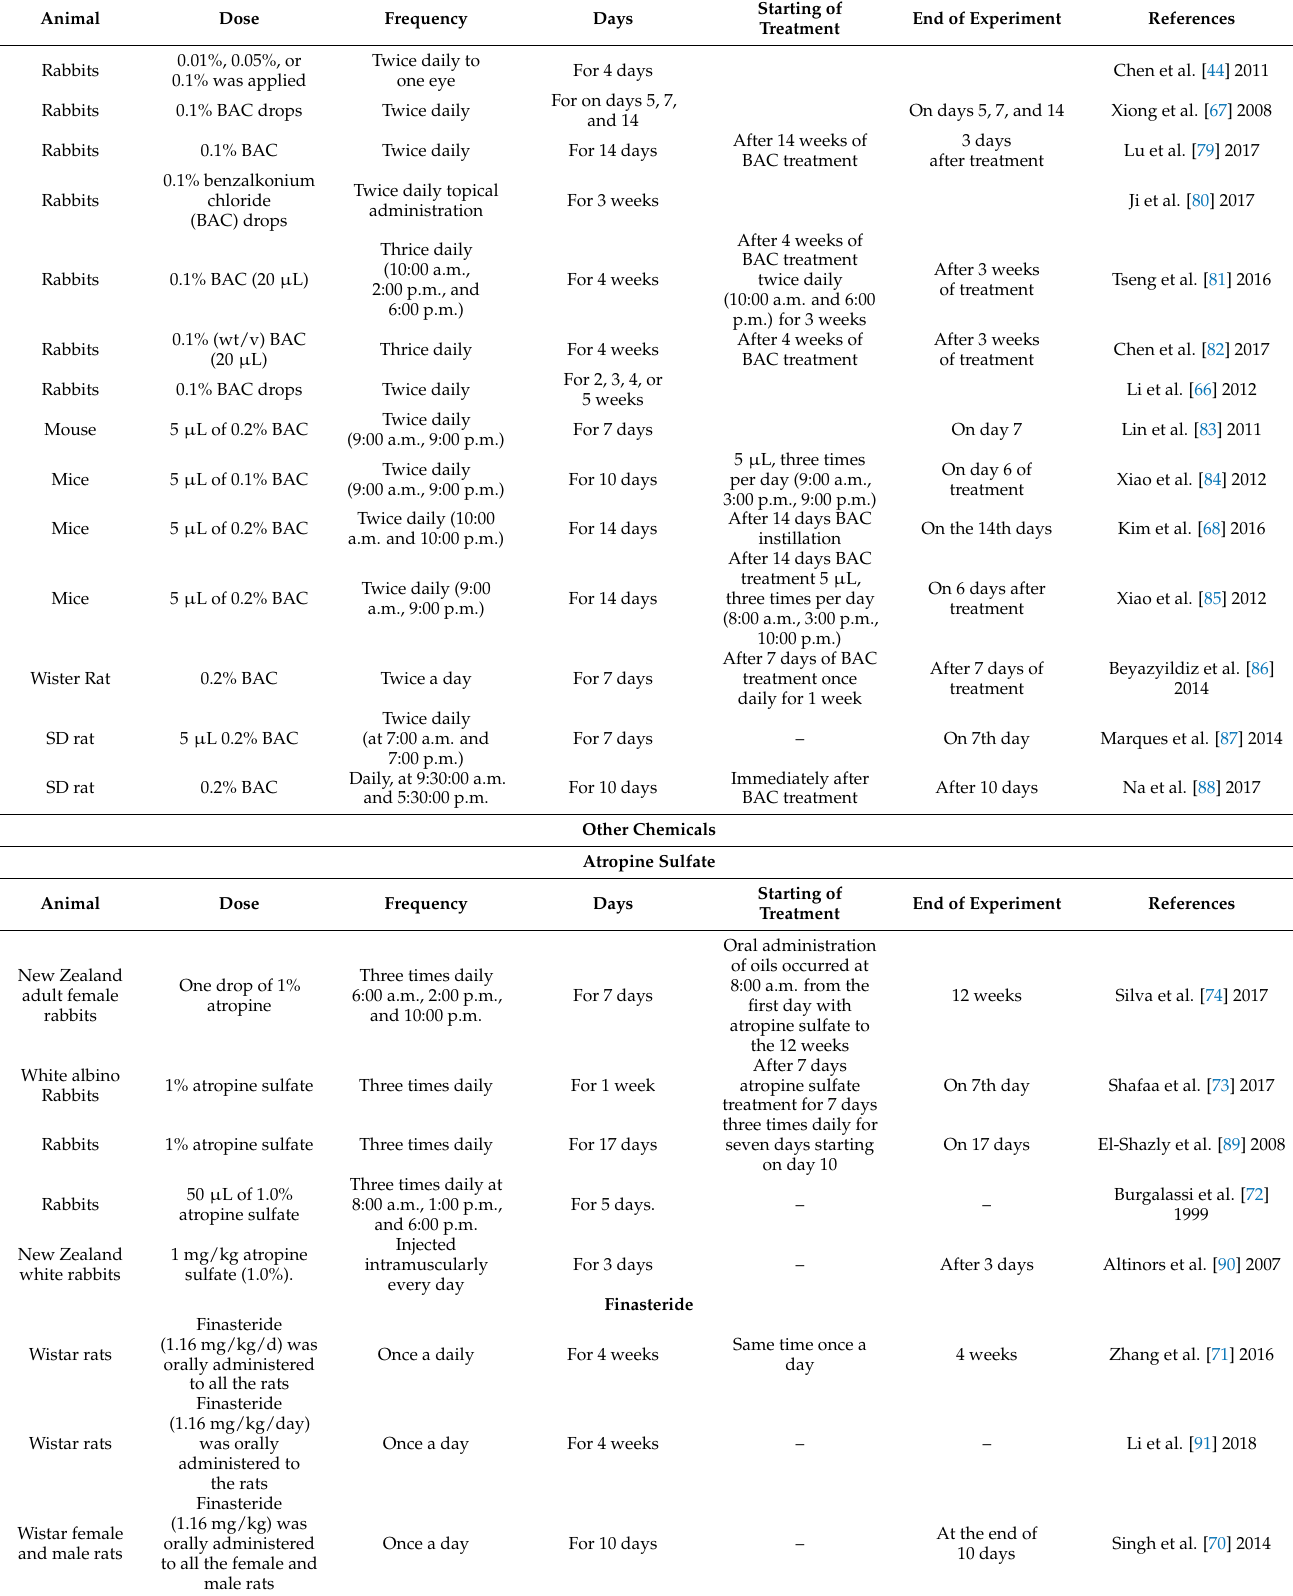
Table 3. Experimental protocol in chemically induced DED